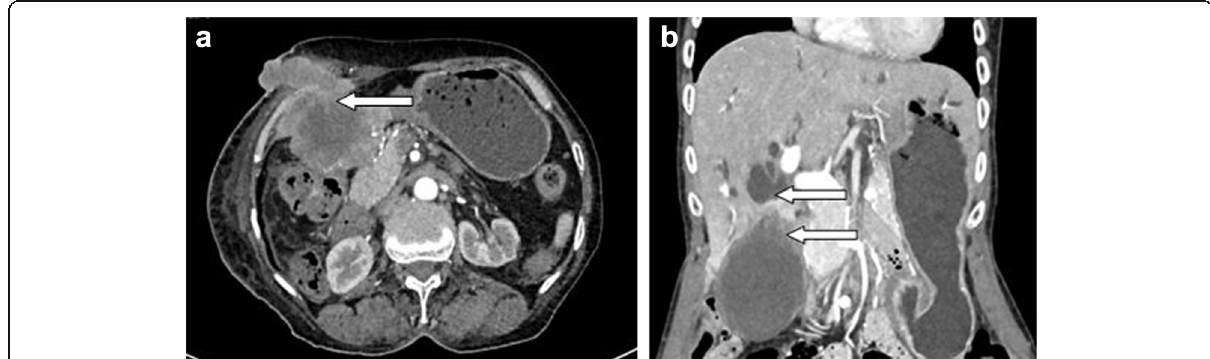
Fig. 4 Axial CECT image shows an irregular, exophytic mass lesion invading the anterior abdominal wall and the adjacent small bowel loops ( a ); coronal CECT image shows dilated intrahepatic biliary ducts due to an eccentric GB wall carcinoma ( b